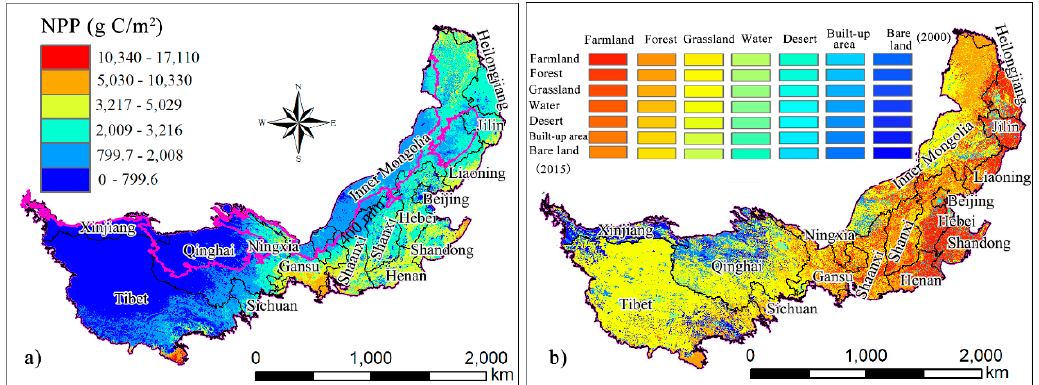
Figure 4. Mean annual NPP from 2000 to 2015 ( a ) and the spatial pattern of conversion of land use types from 2000 to 2015 ( b ).